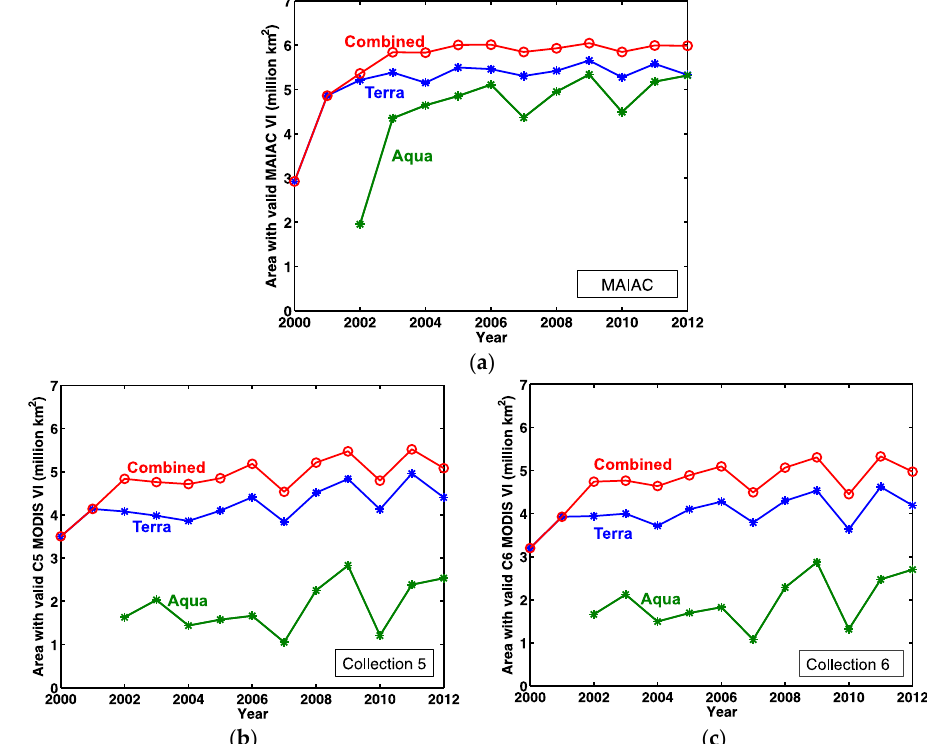
Figure 1. MAIAC products provide more valid observations than both Collection 5 and Collection 6 MODIS products over the Amazon forests in the Amazonian dry season, and the Terra-Aqua combined products yield more valid observations than the Terra or Aqua product alone. ( a ) Area of Amazon forests with valid dry season mean vegetation index from MAIAC data; ( b ) Area of Amazon forests with valid dry season mean vegetation index from Collection 5 MODIS VI product; ( c ) Area of Amazon forests with valid dry season mean vegetation index from Collection 6 MODIS VI product. The vegetation index used for this figure is NDVI. The area of the Amazonian forests is 6.4 million km 2 . The area of forests with valid dry-season Terra-Aqua combined standard (Collection 5 and Collection 6) MODIS VI retrievals is around five million km 2 , which is ~80% of the area of the Amazon forests. When using the Terra product alone, we get valid dry season VI over only ~60% of the Amazon forests. The Terra-Aqua combined MAIAC VI product provides valid dry season VI covering around six million km 2 forests, which is ~95% of the Amazon forests, in each year after 2003. The consistent high percentages of valid dry-season mean MAIAC VI retrievals over the Amazon forests allow a much more complete assessment of the response of Amazon forests’ photosynthetic activity to droughts than using standard MODIS VI products.